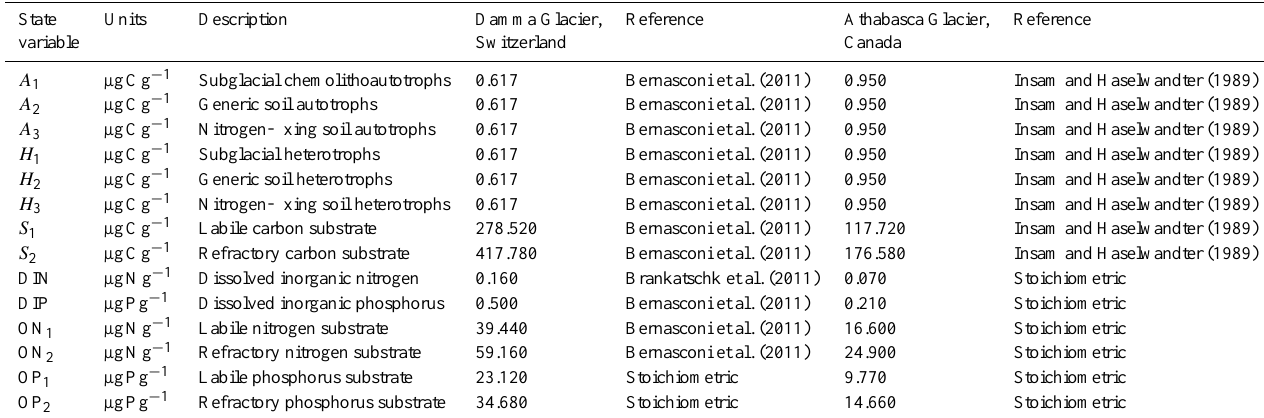
Figure 3. A conceptual model showing the components and transfers of SHIMMER. State variables are indicated with shading. Table 2. State variables and initial